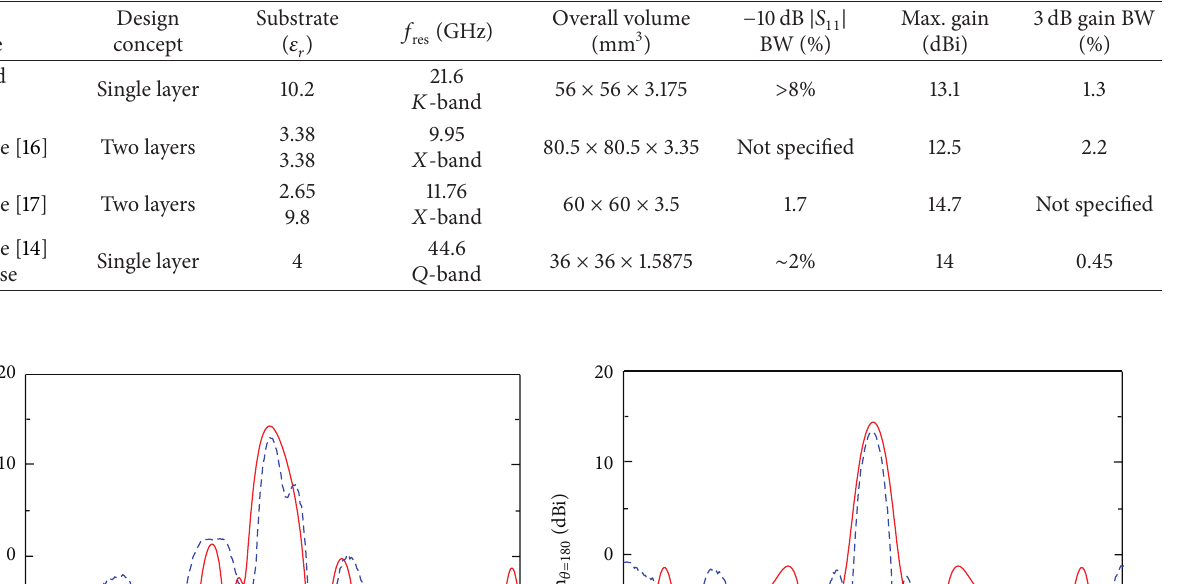
Table 2: Comparison of the proposed antenna with low-profile high-gain Fabry-P´erot cavity antennas. The two-layer design means that two substrates of feeding and FSS structures are closely appressed to each other.